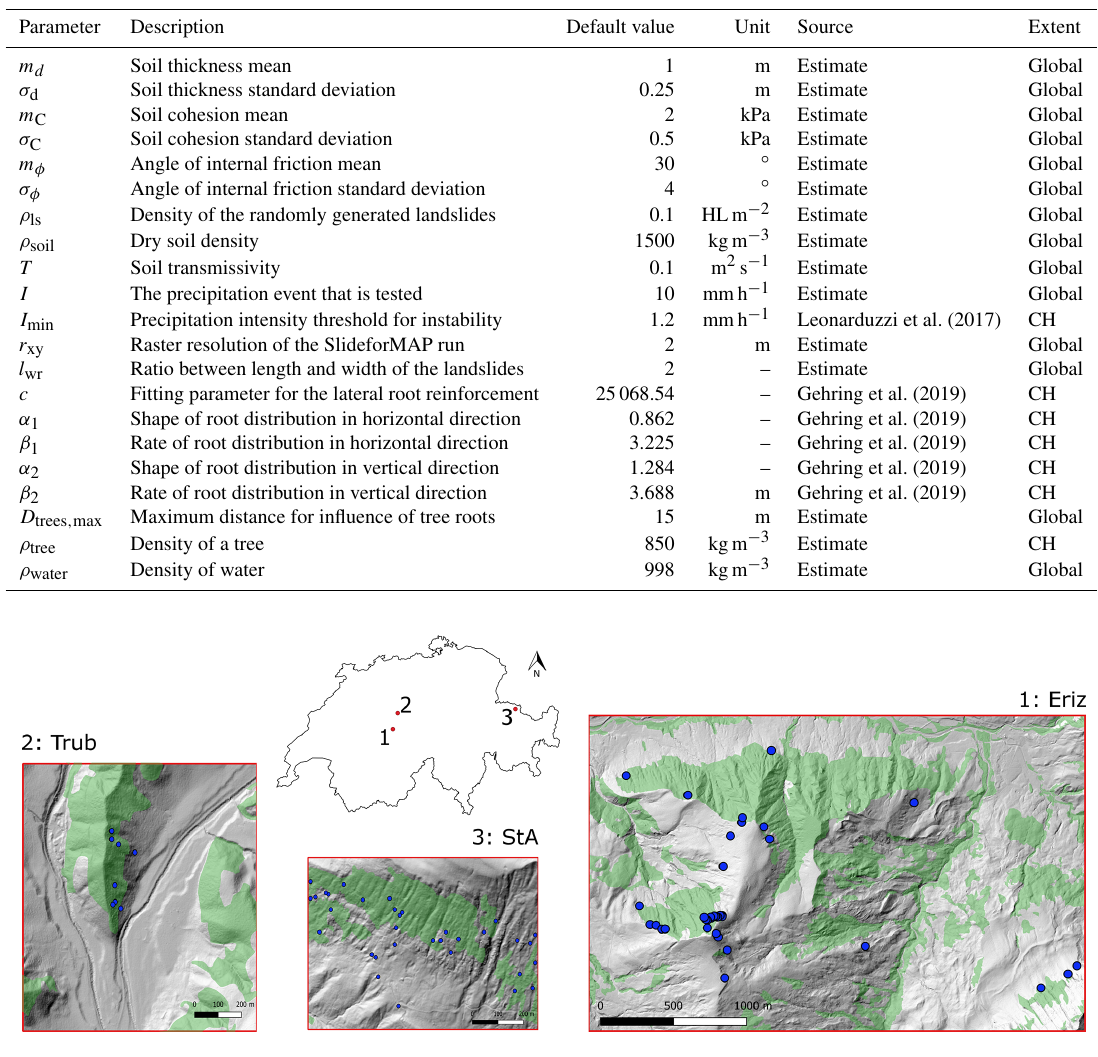
Figure 3. Locations of the study areas in Switzerland with observed shallow-landslide occurrence over the period 1997–2012 (blue dots); the case study names are given according to nearby villages: Trub, St. Antönien and Eriz. Forest-covered area is presented in green. Source of forest cover: Federal Office of Topography swisstopo (Swisstopo, 2020). Source of hillshade: Federal Office of Topography swisstopo (Swisstopo,